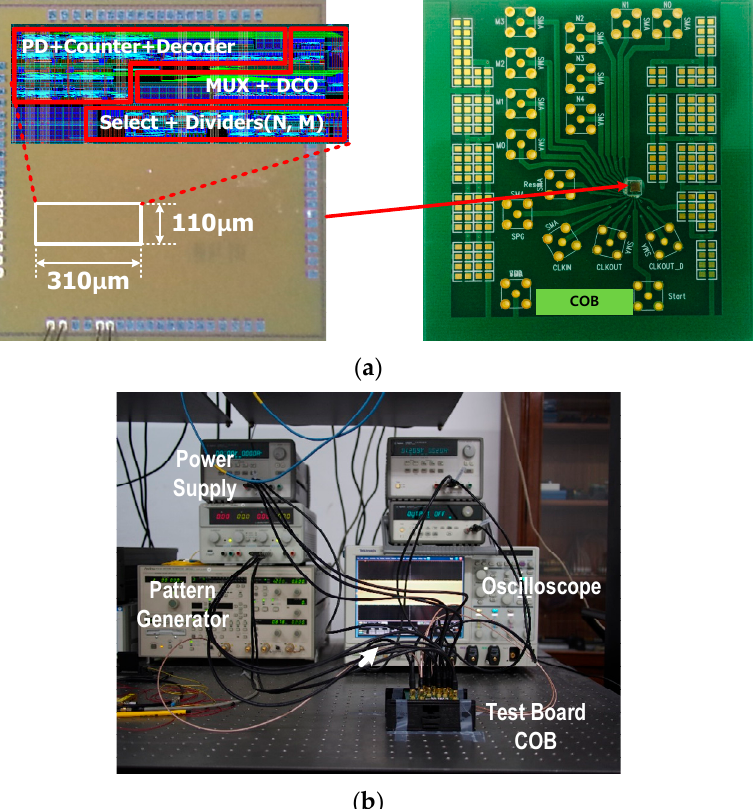
Figure 8. ( a ) Fabricated silicon Chip/Layout and test COB of the proposed N/M ‐ ratio MDLL clock generator. ( b ) Measurement setup.